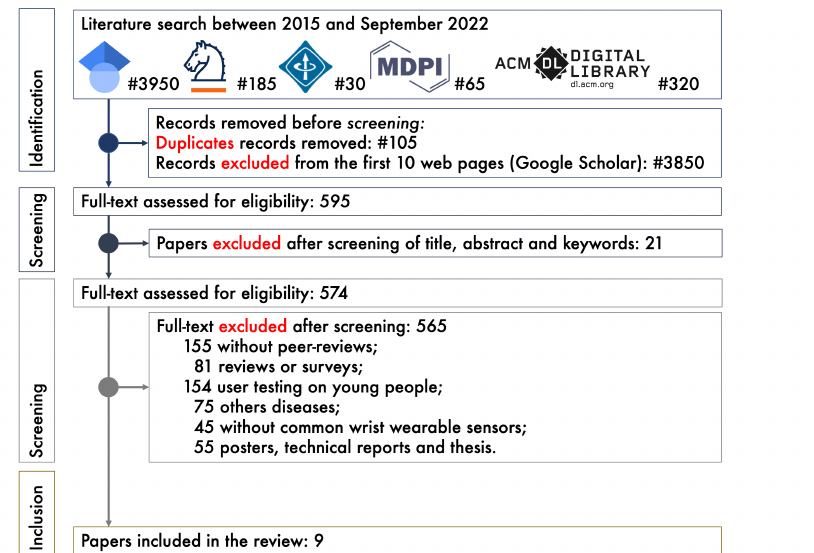
Figure 1. PRISMA flow diagram for the systematic